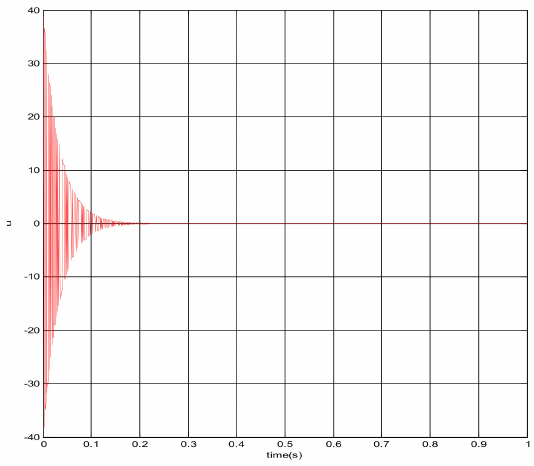
Figure 12. The changing curve of control quantity